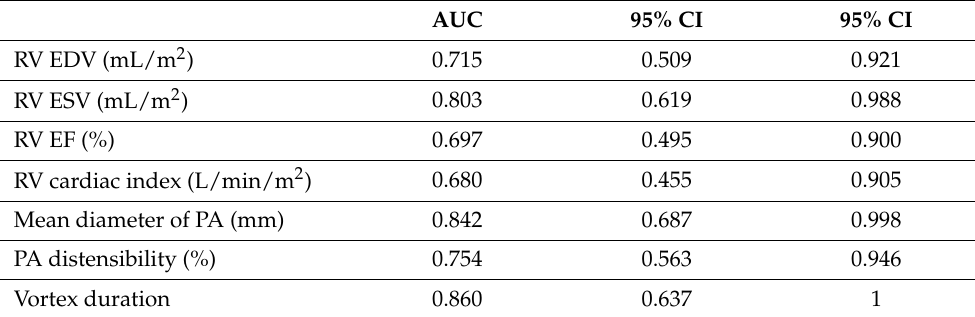
Table 4. Receiver operating characteristic curve analysis of MR parameters to detect pulmonary hypertension (mean pulmonary pressure > 20 mmHg on RHC).